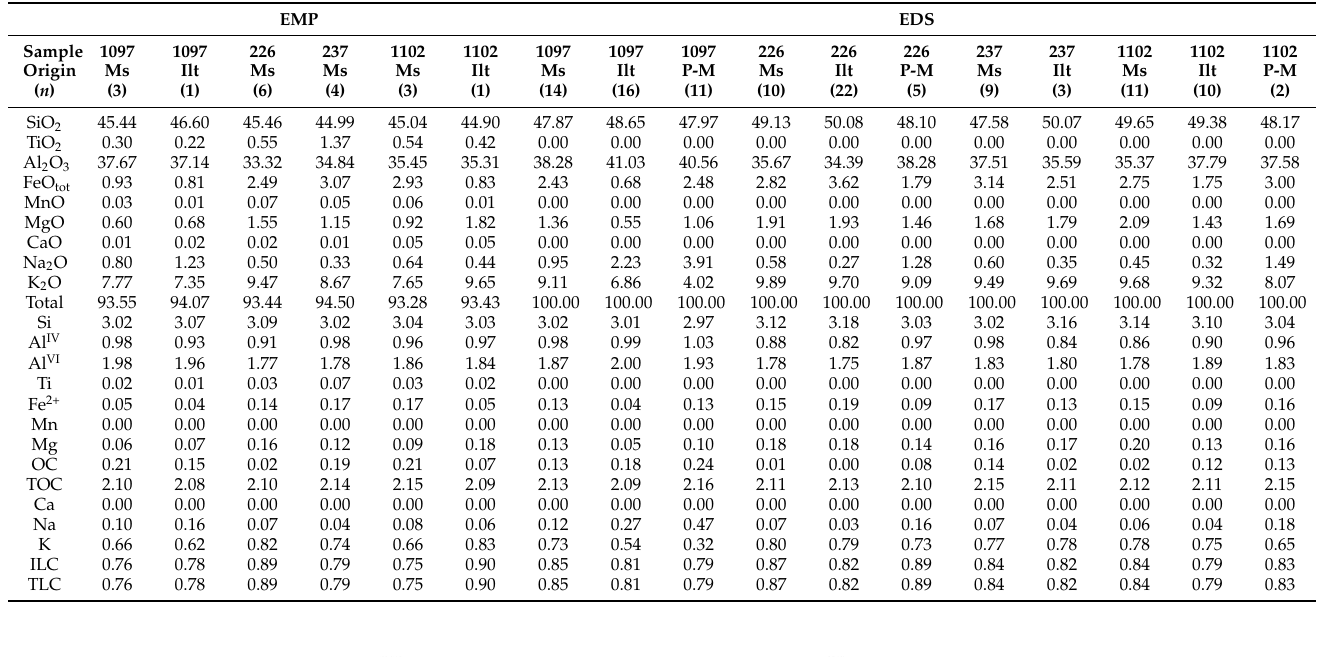
Table 4. Average chemical composition and structural formulae of illite/micas of the early Paleozoic rocks from the Eastern Tauride Belt (Ms = Muscovite, Ilt = Illite, P-M = Paragonite-muscovite).